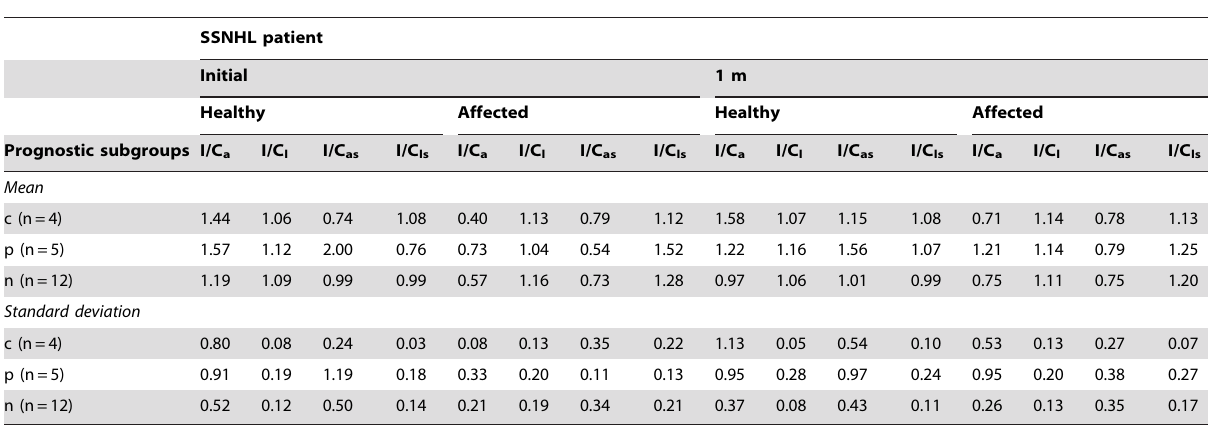
Table 5. Ipsilateral/contralateral ratio of N100m in prognostic subgroups.